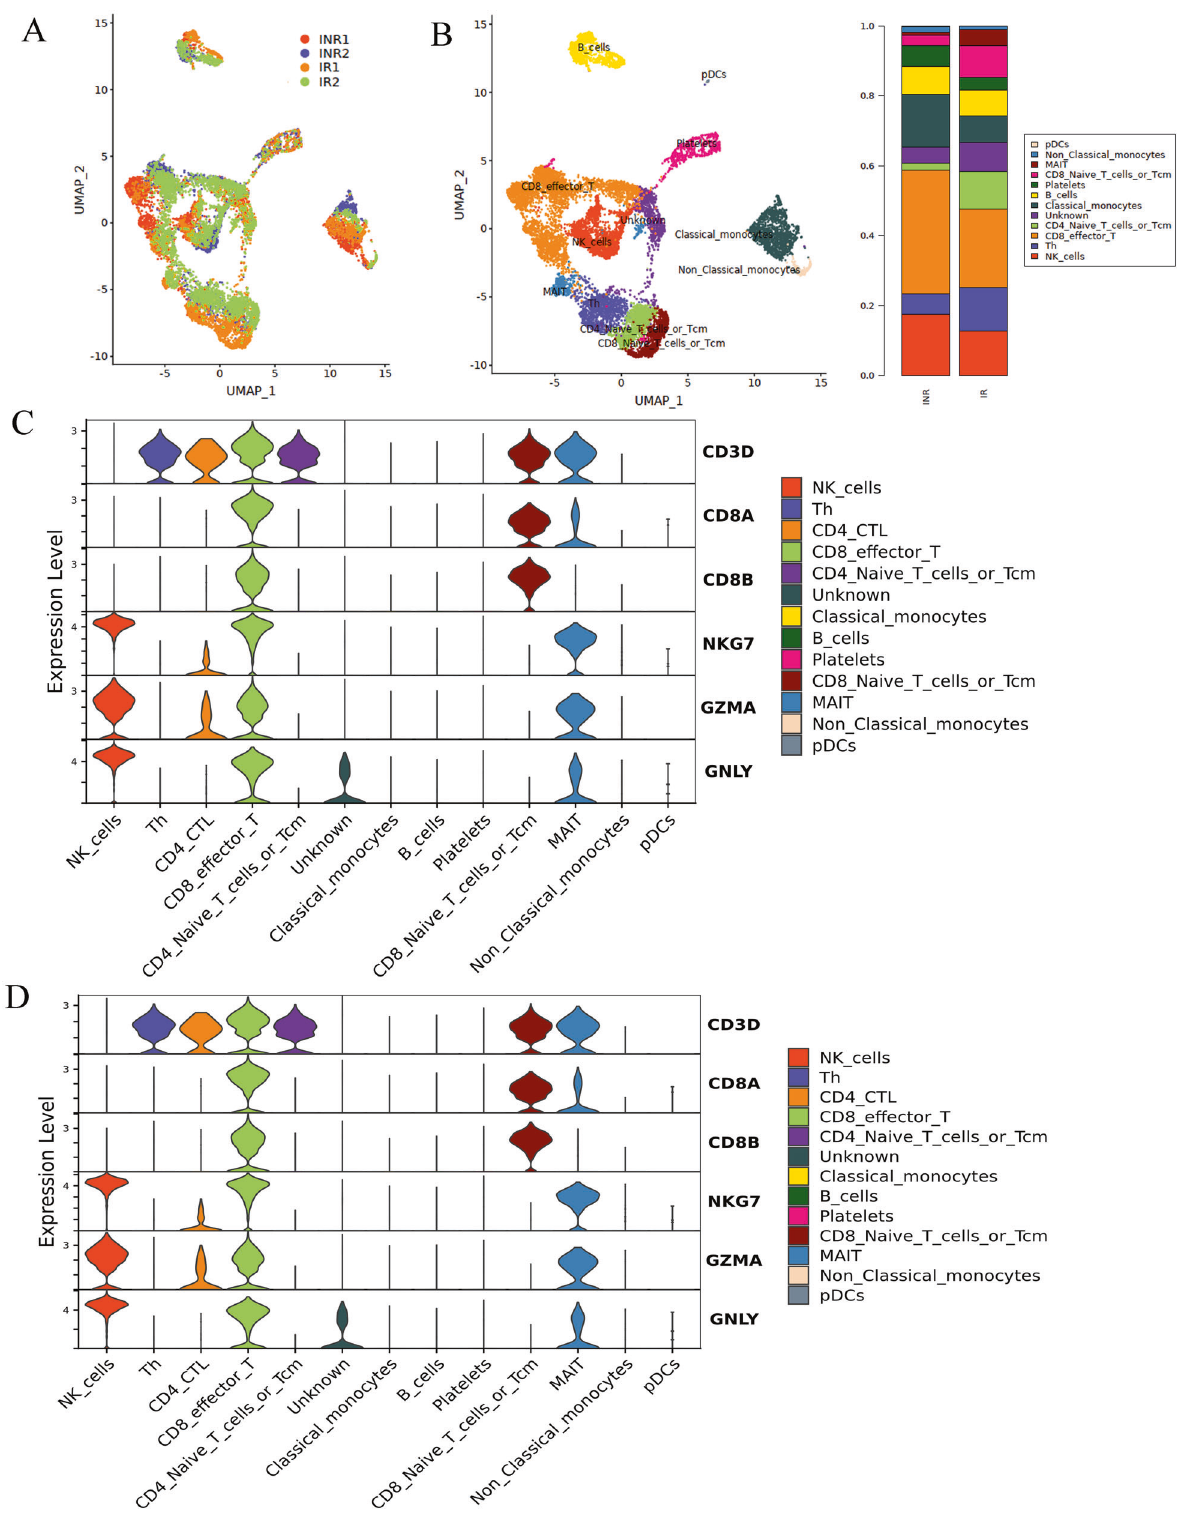
Fig. 1 Single-cell transcriptional pro fi ling of PBMCs derived from IR and INR patients with HIV-1-infected. A Two-dimensional UMAP visualization of PBMCs for IRs and INRs. Different colors represent different sample sources. B Different colors represent 10 clusters (cell types) de fi ned by the k -means clustering algorithm. Different colors represent 11 cell types. The UMAP projection of 12086 single cells from IR and INR samples shows 11 clusters with the respective labels. Each dot corresponds to a single cell, colored according to cell type. C , D Stacked violin plots showing the expression distribution of selected canonical cell markers in the CD8 MAIT T cells.